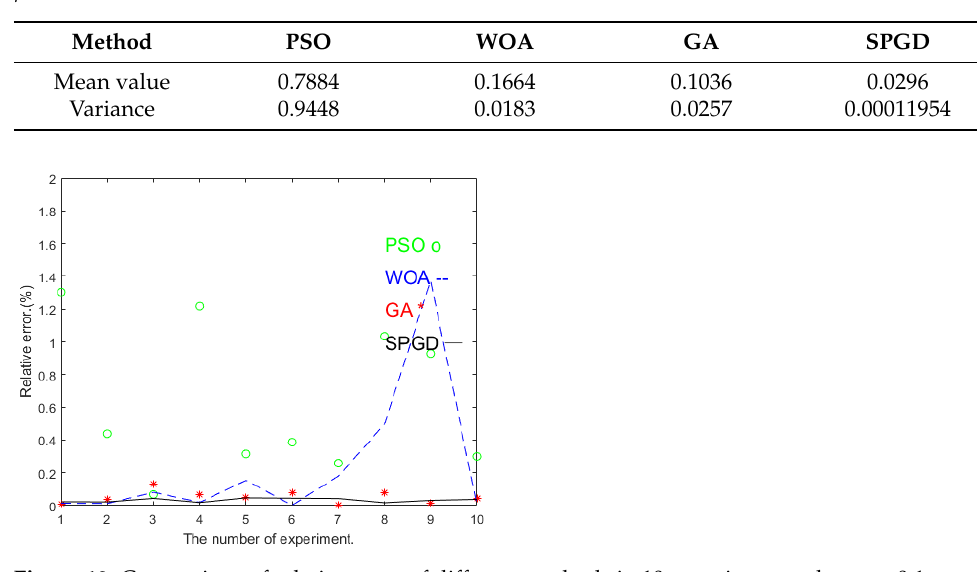
Figure 9. Comparison of relative error of different methods in 10 experiments when µ = 0.05. Table 2. The mean values and variances of relative error in 10 experiments in different methods when µ = 0.05.